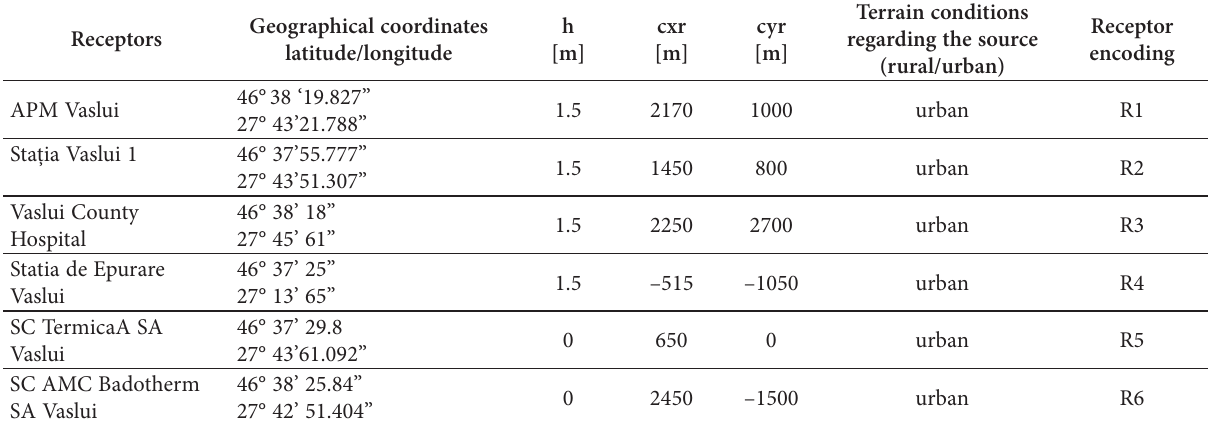
Table 3. Input data – receptors for Pol 15sm model